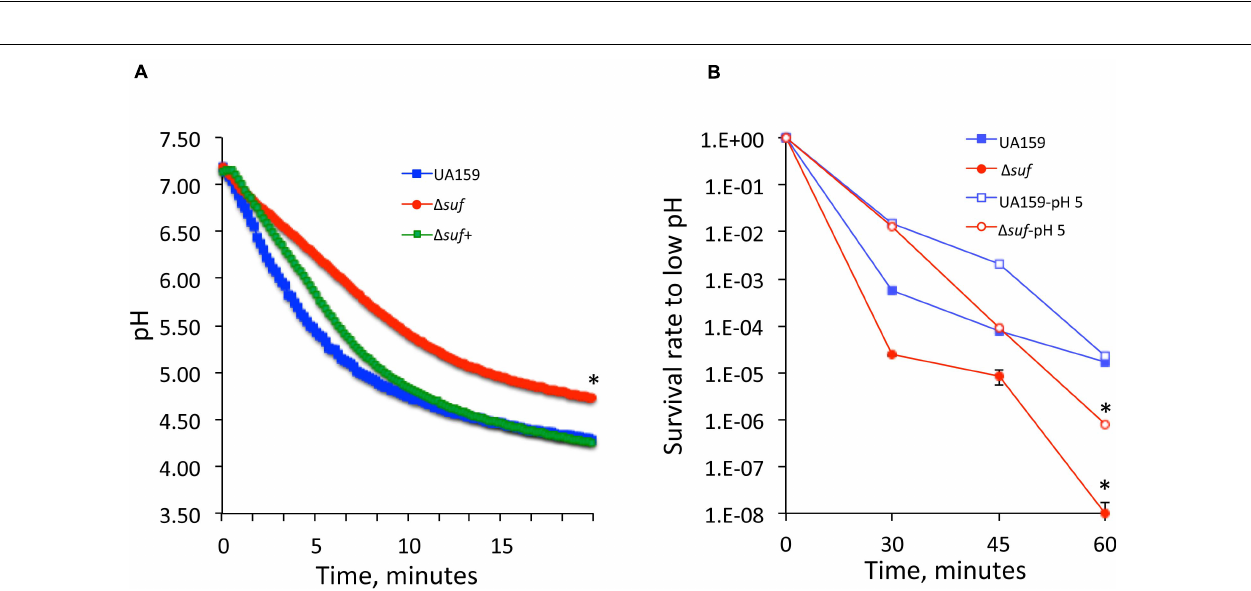
FIGURE 2 | Growth studies in the absence of selected amino acids. Streptococcus mutans wild-type, UA159 and the sufCDSUB- deficient mutant, (cid:49) suf::kan r ( (cid:49) suf ) were grown in (A) FMC medium, (B) FMC medium with omission of isoleucine, (C) FMC medium with omission of leucine, (D) FMC medium with omission of glutamic acid (Glu) and glutamine (Gln). Data presented are representatives of three separate experiments. Symbol * and # indicates a statistical significance at P < 0.05 and P < 0.001, respectively, when compared to UA159 under the same conditions tested.